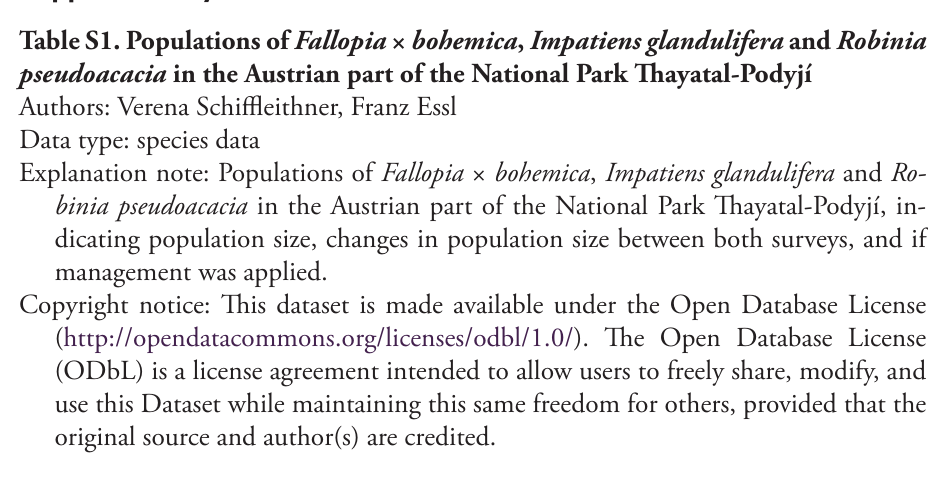
Table S1. Populations of Fallopia × bohemica , Impatiens glandulifera and Robinia pseudoacacia in the Austrian part of the National Park Thayatal-Podyjí